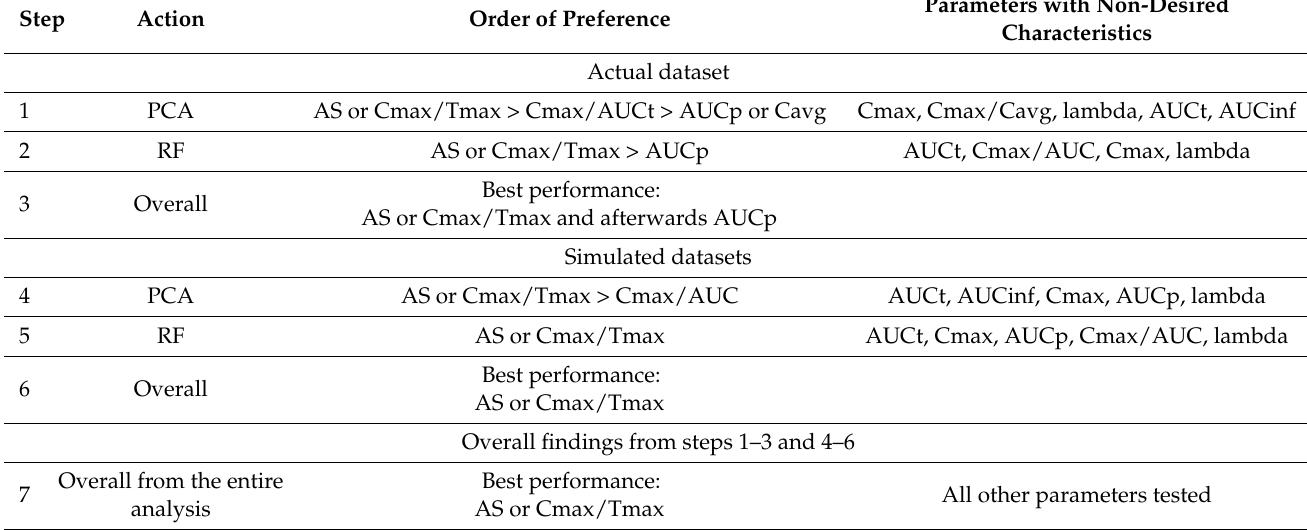
Table 4. The stepwise process of analysis allowed screening the pharmacokinetic parameters with the desired behavior. Within each step of the analysis, the pharmacokinetic parameters are listed in the order of preference